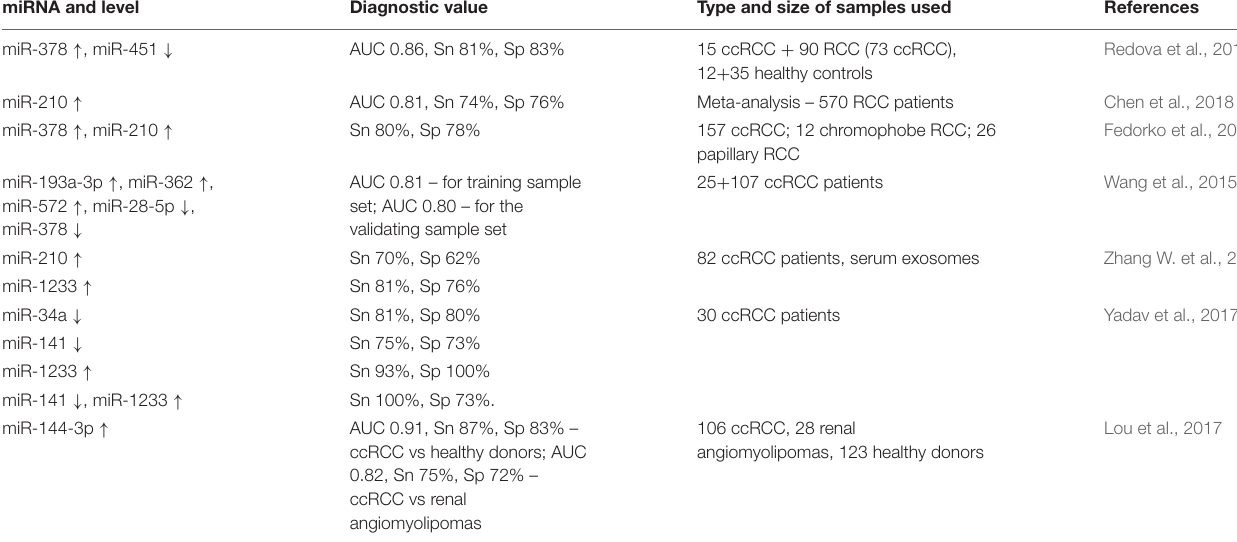
TABLE 2 | Non-invasive markers suggested for use in ccRCC diagnosis: miRNA level and diagnostic value. miRNA and